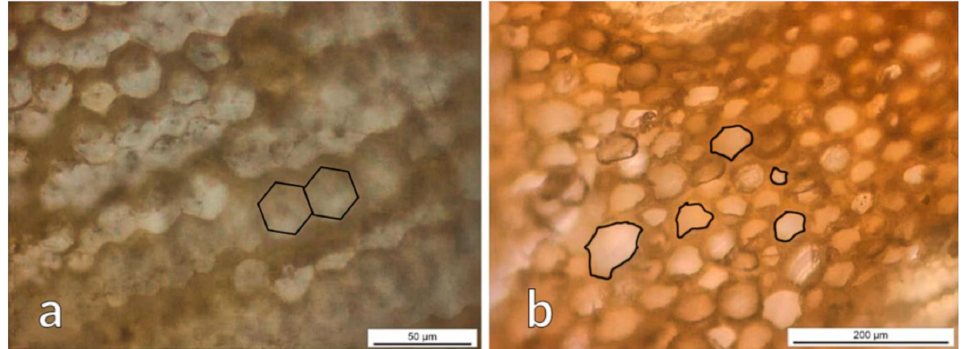
Figure 4. Optical micrographs from the transition zone of AA bamboo: ( a ) transversal cut of fiber sheaths and ( b ) transversal cut of